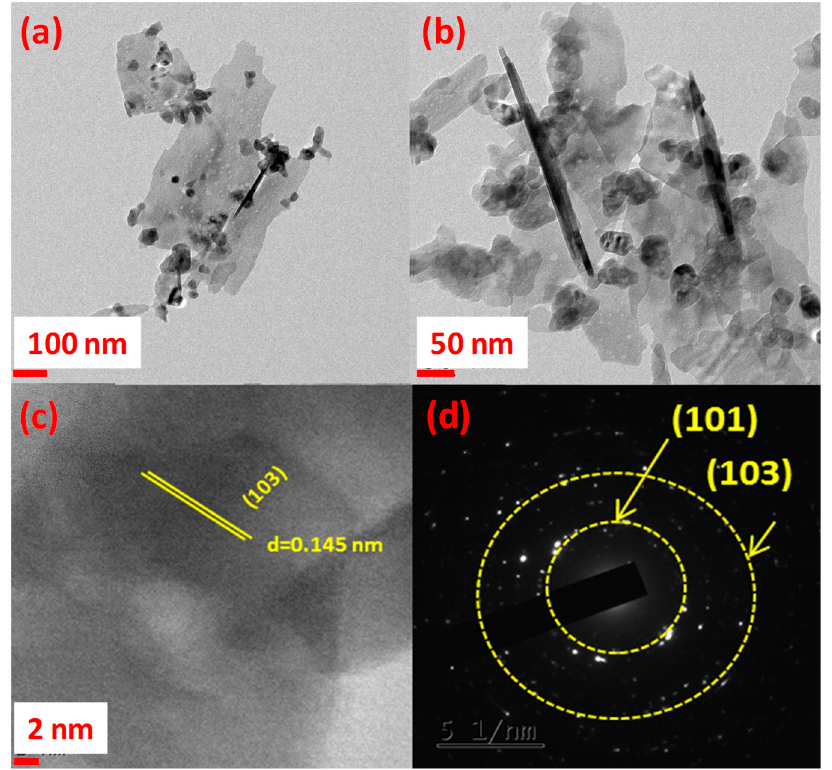
Figure 3. ( a ), ( b ) TEM images. ( c ) HR-TEM images. ( d ) SAED pattern of material of S. persica leaf extract.